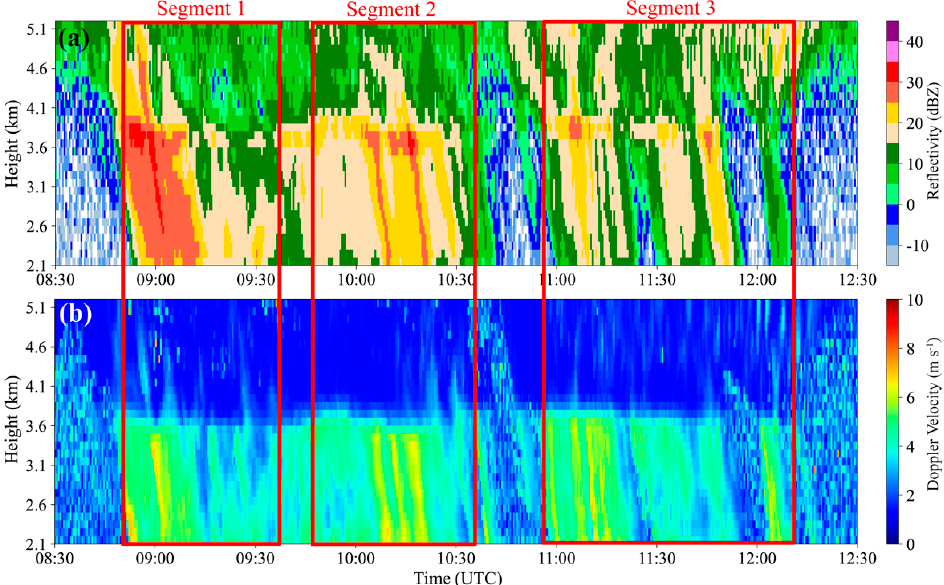
Figure 4. Time − height diagram of ( a ) reflectivity and ( b ) Doppler velocity measured by the MRR. The drop size distributions, concentrations, and VMDs below the melting layer in the three precipitation segments are shown in Figure 5, respectively. It can be seen that the drop size distributions broadened as the rain fell toward the ground in all the segments (Figure 5a–c), indicating that the accumulation of drops was occurring, and the maximum drop diameter increased from 4 mm to approximately 4.6 mm as the rain fell from the melting layer to the